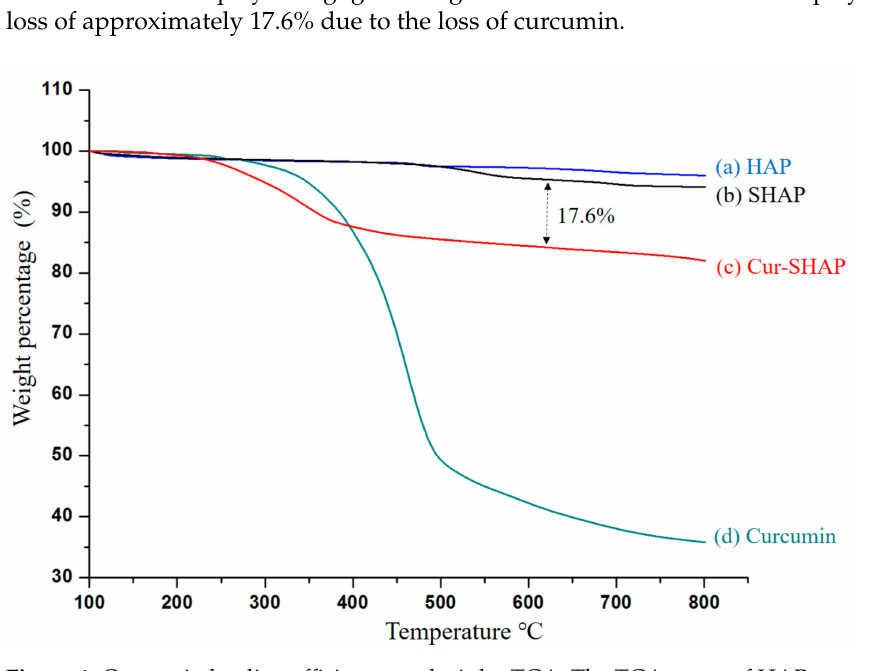
Figure 4. Curcumin loading efficiency analysis by TGA. The TGA curve of HAP, curcumin, SHAP, and Cur-SHAP is shown. Approximately 17.6% weight loss was due to the loss of